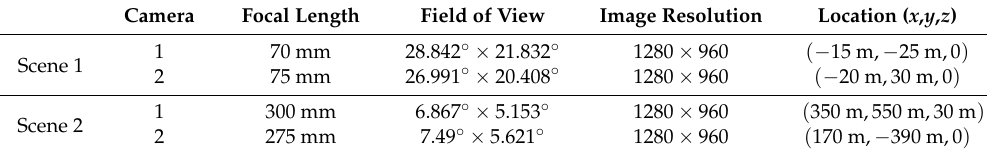
Table 1. The internal parameters and spatial layouts of the cameras in Scene 1 and Scene 2.